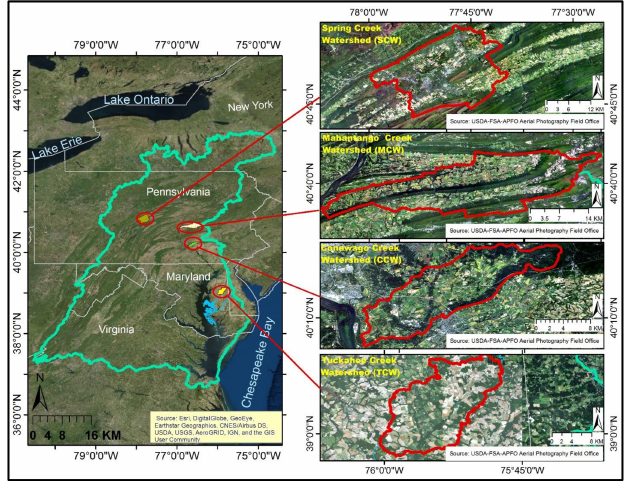
Figure 1. Location of the study watersheds relative to the Chesapeake Bay Watershed: Spring Creek (SCW), Mahantango Creek (MCW), Conewago Creek (CCW) and Tuckahoe Creek (TCW) watersheds. Runoff from the Conewago Creek (CCW = 136 km 2 ), Mahantango Creek (MCW = 420 km 2 ) and Spring Creek (SCW = 378 km 2 ) watersheds drains to the Susquehanna river, the largest river in the Chesapeake Bay